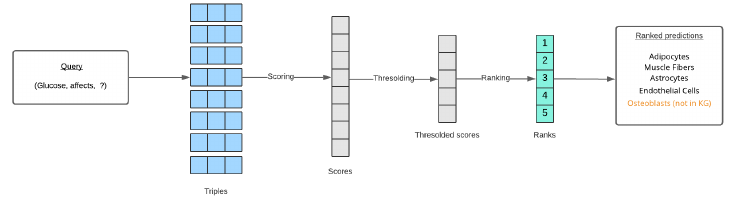
Figure 8. The end-to-end process of ranking link prediction results for a given query.